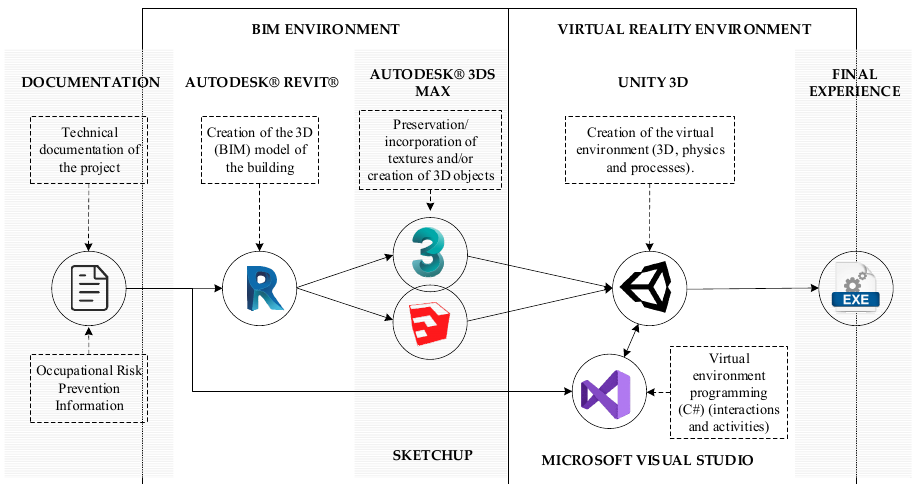
Figure 11. Tools for the development of virtual reality experiences. Table 1. Technical details of the tools used. Tool